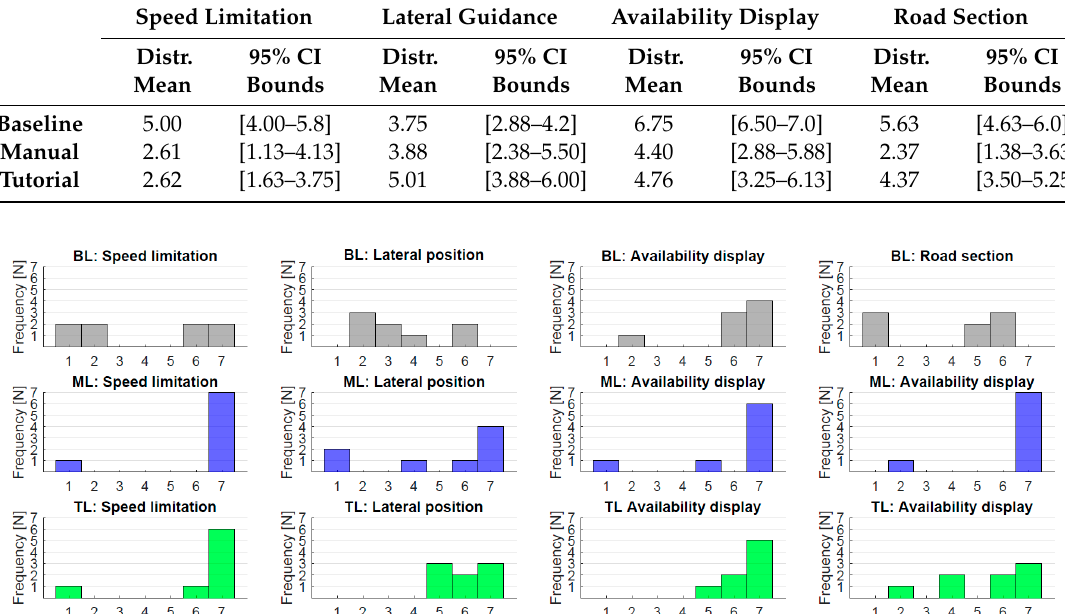
Figure 5. Frequency [n] of L3 ADS mental model ratings [1–7] for the four relevant items (columns) by experimental condition (rows 1–3: baseline grey, owner’s manual blue, tutorial green). Table 8. Means and 95% CI upper and lower bounds of bootstrapped mental model distributions for the four relevant items on L3 automation by the three experimental conditions.